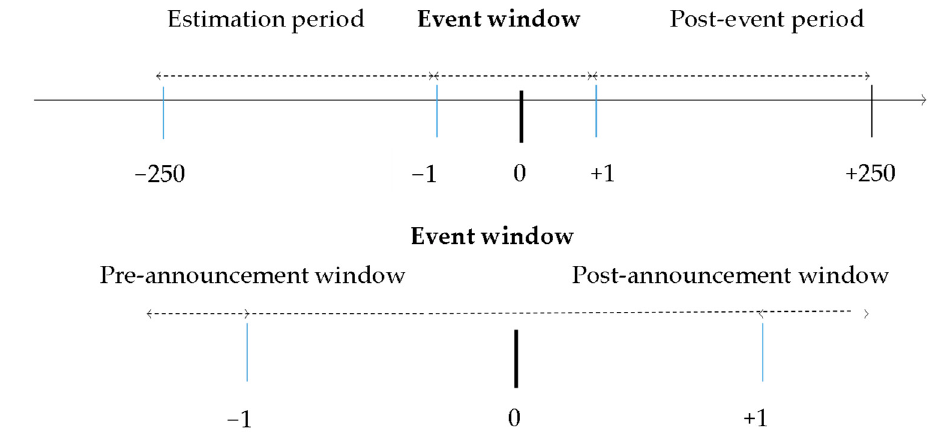
Figure 3. Event study window for cumulative abnormal returns (robustness analysis).